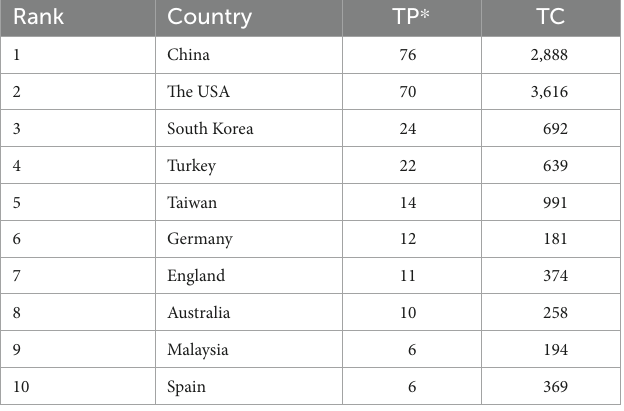
TABLE 5 Top 10 countries with most publications in the DA–depression domain.